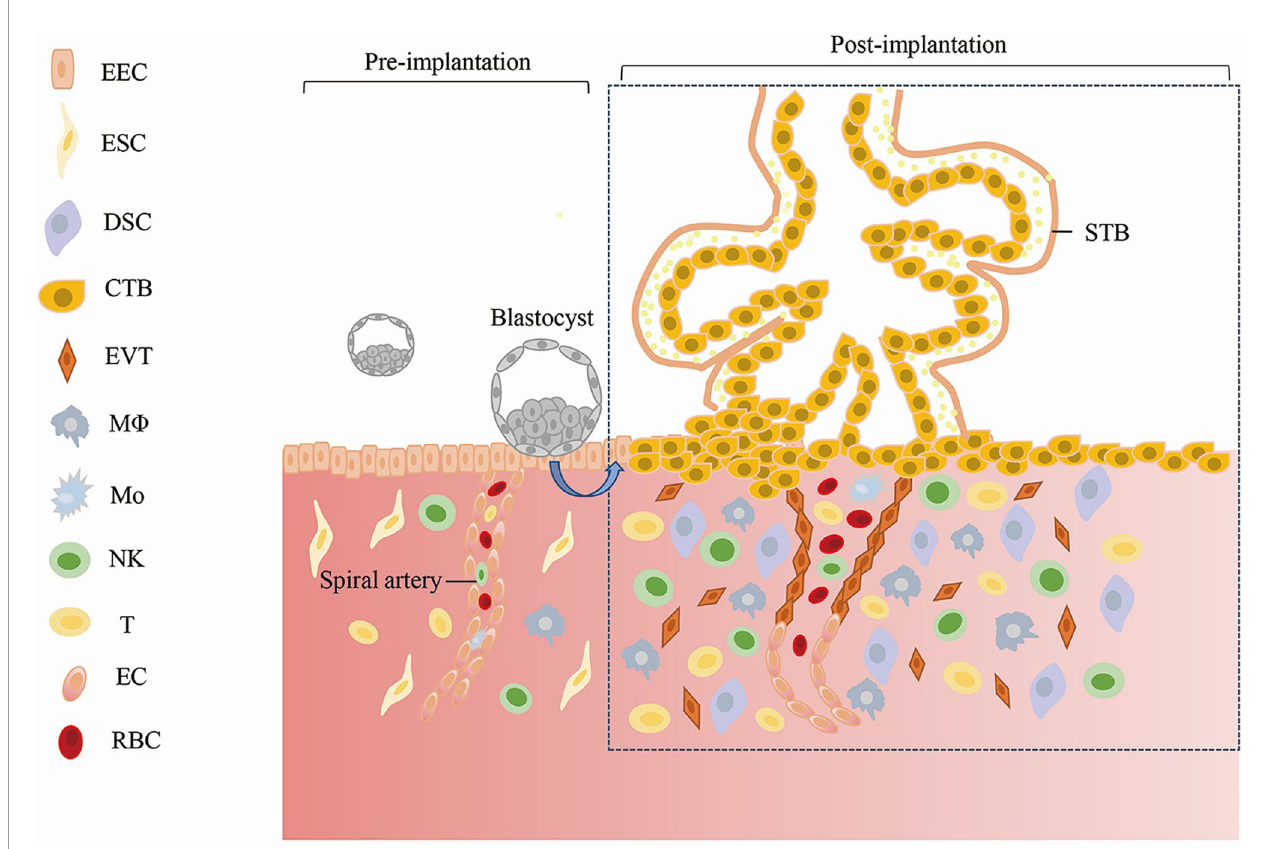
FIGURE 1 | Establishment and Maintenance of Early Pregnancy. EEC, Endometrial Epithelial; Cell ESC, Endometrial Stromal Cell; DSC, Decidual Stromal Cell; CTB, Cytotrophoblast; STB, Syncytiotrophoblast; EVT, Extravillous Trophoblast; M F , Macrophages; Mo, Monocyte; NK, Natural Killer Cell; EC, Endothelial Cell; RBC, Red Blood